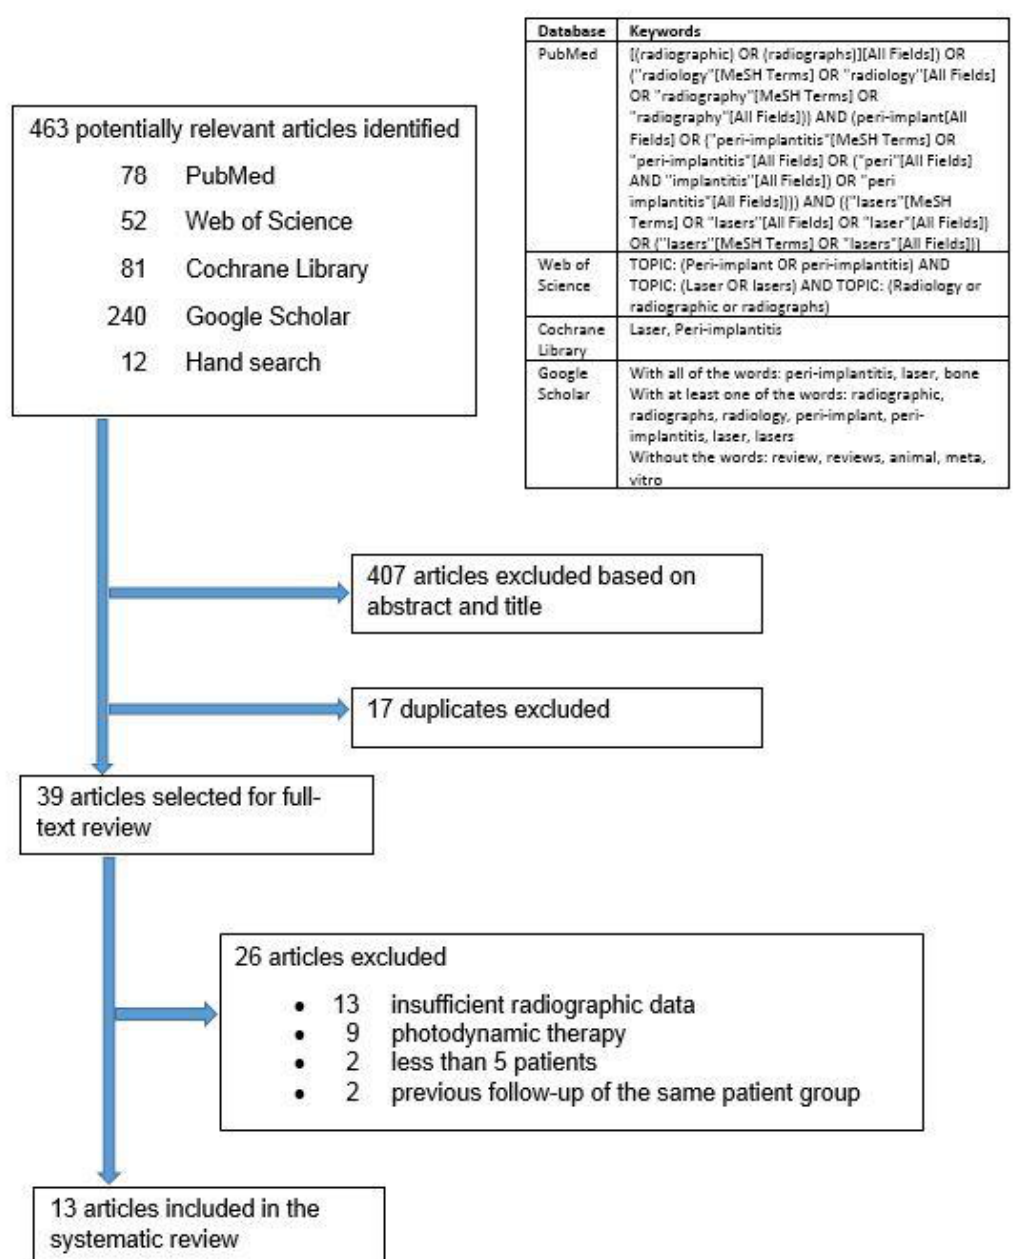
Figure 1. Search Figure 1. Search strategy.